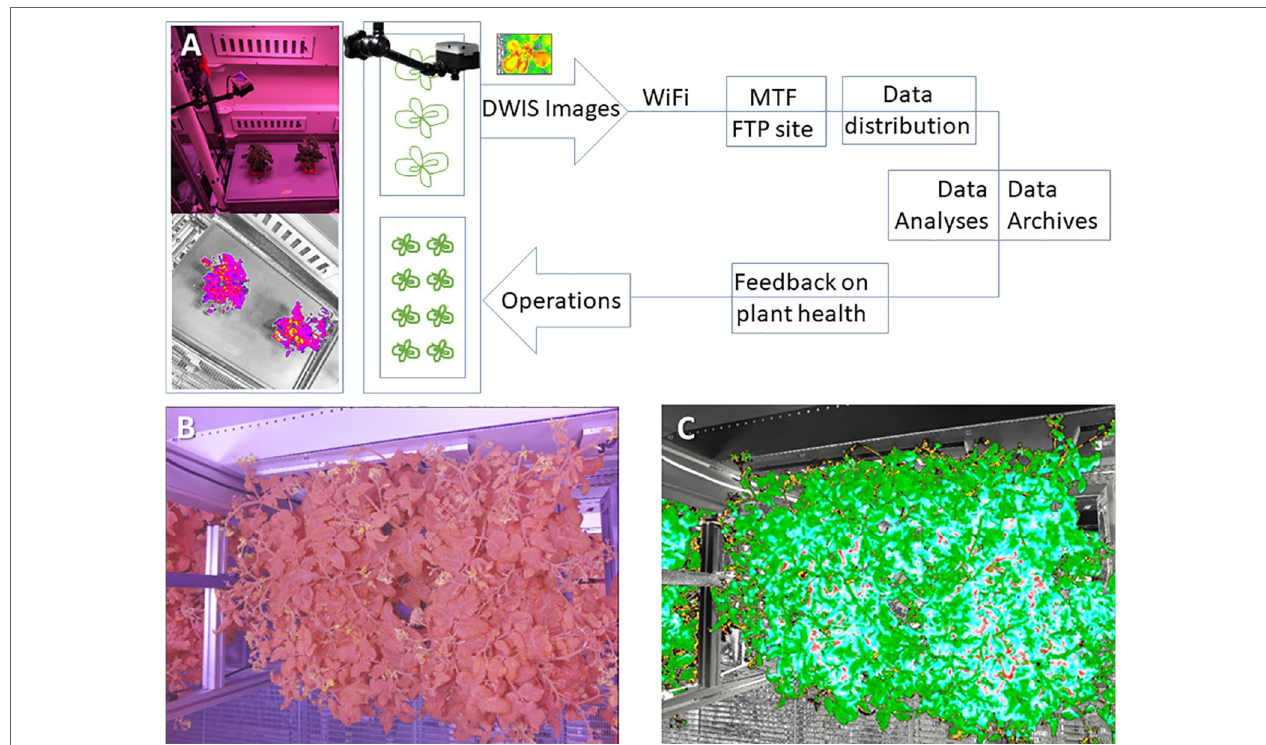
FIGUrE 10 | (A) The basic information path that was used for the Dual Wavelength Spectral Imaging System (DWIS) integrated into the FEG. (B) An example of an unprocessed image taken by the Dual Wavelength Spectral Imaging System over the tomato growth tray. The filter in the imager removes most of the green wavelength from the image. (c) A false colored NDVI processed version of the image in (B) . The false coloring is provided by a Look Up Table for the NDVI pixel values. The Look Up Table can be varied to adjust the visual presentation of the processed values within each pixel (Beisel et al., 2018). In this example, all of the leaves are essentially healthy and this example shows the range of NDVI pixel false-color values in healthy tomato plants.